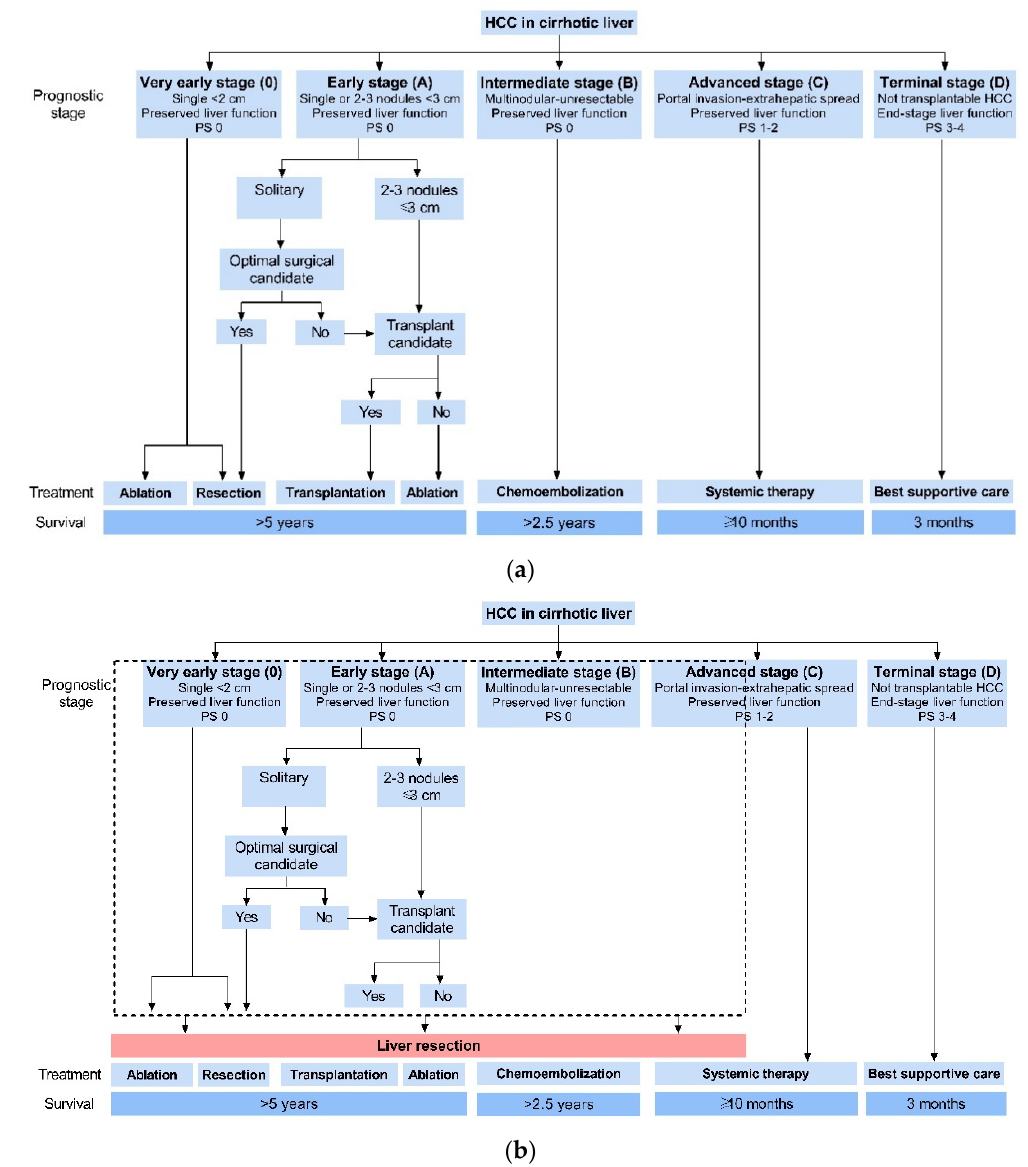
Figure 1. ( a ) Modified Barcelona clinic liver cancer (BCLC) staging and treatment algorithm. ( b ) Real-worldwide clinical practice.